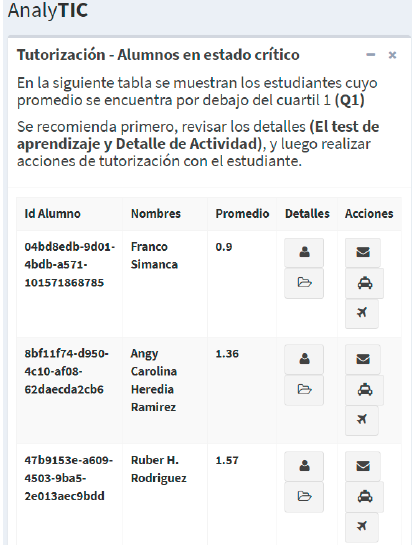
Figure 7. The options that the teacher has for tutoring students at a critical stage are displayed: Details (learning style and general activity) and actions (send email, send study material, send reminder of activities due).